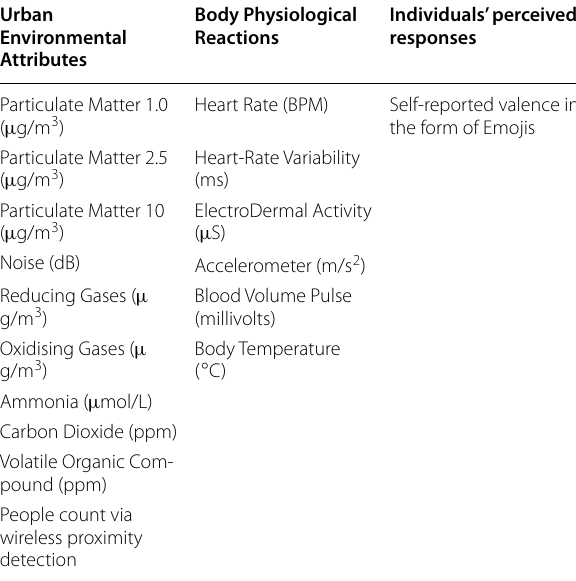
Table 1 DigitalExposome dataset variables and